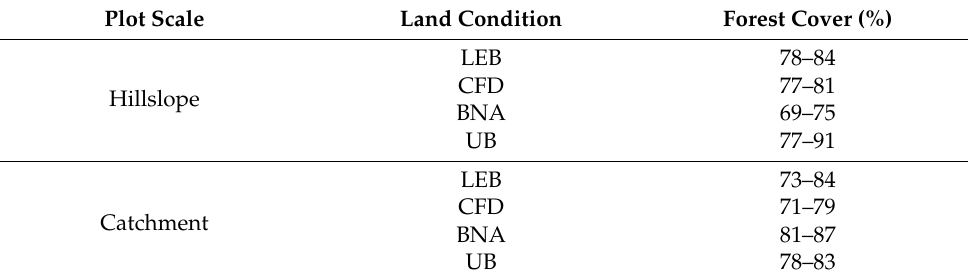
Table 1. Pre-fire forest cover in plots under four land conditions before the wildfire of 2012 in Sierra de los Donceles forest (Castilla-La Mancha, Spain). Plot Scale Land Condition Forest Cover (%) LEB 78–84 CFD 77–81 Hillslope BNA 69–75 UB 77–91 LEB 73–84 CFD Catchment BNA